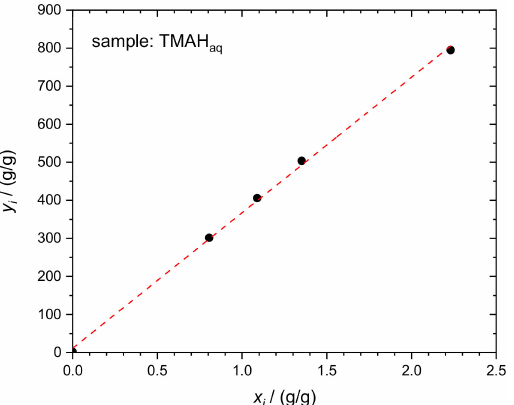
Figure 3. Linear regression evaluation of the Si mass fraction in TMAH aq according to Equation (2). Dataset in Table 2.